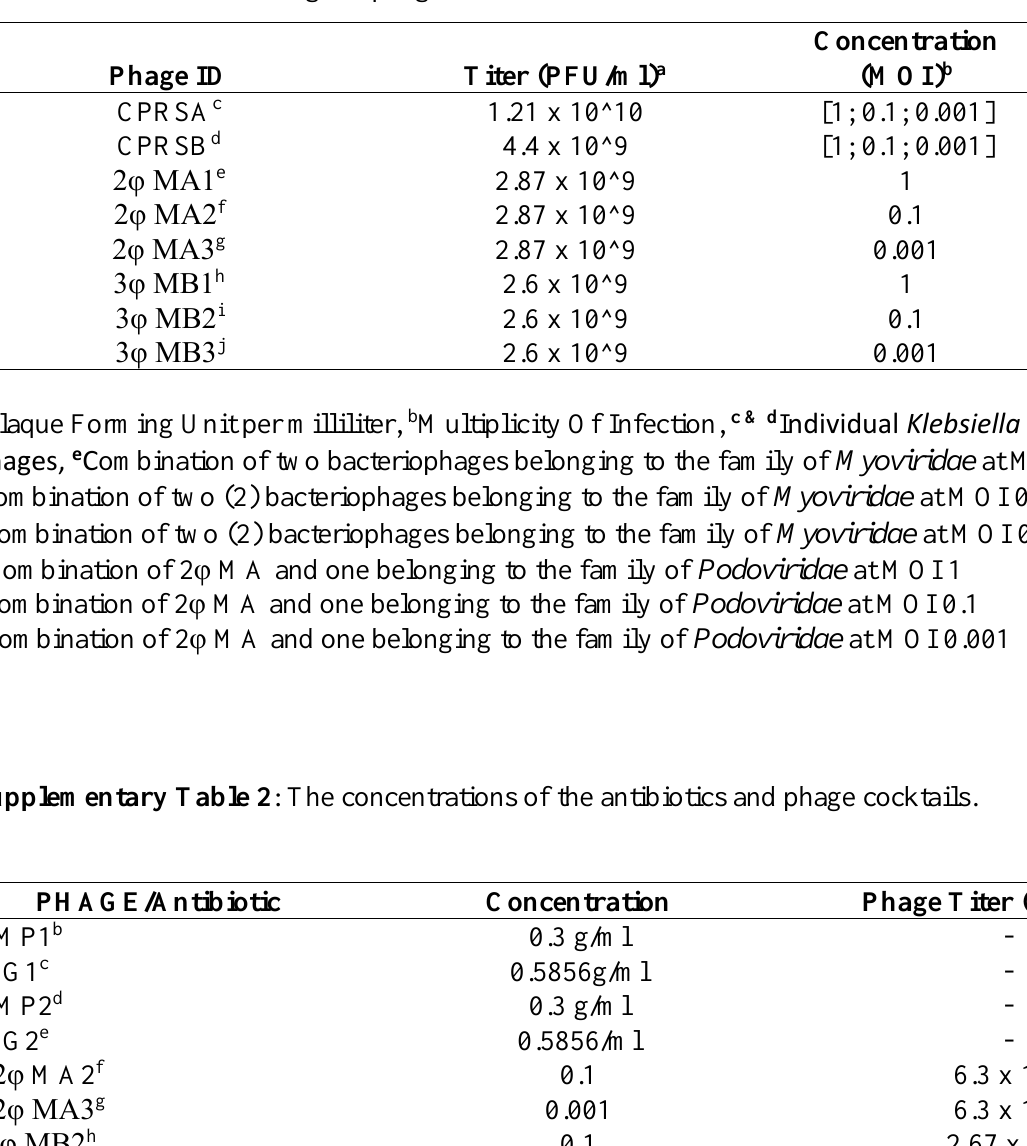
Supplementary Table 1: The concentrations of the individual bacteriophages and phage cocktails used in formulating the phage cocktails.